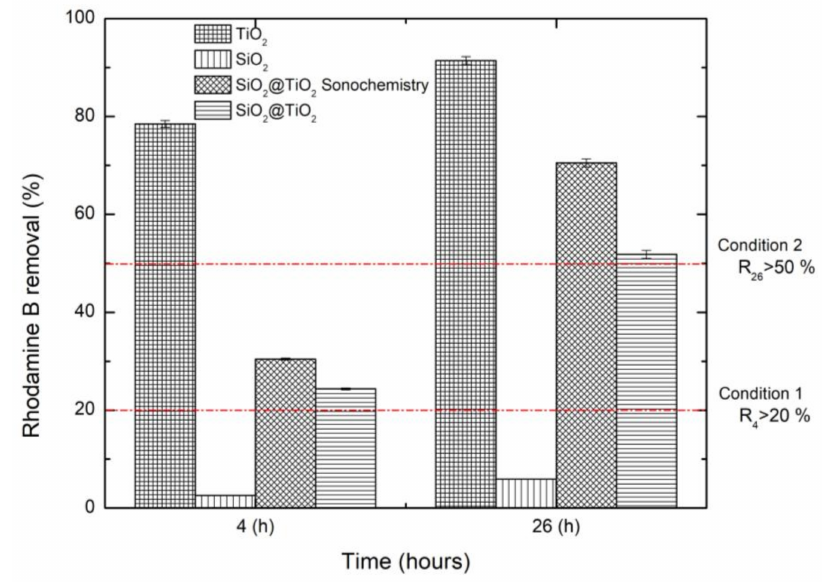
Figure 10. Rhodamine B removal efficiencies of the TiO 2 , SiO 2 and SiO 2 @TiO 2 coated mortar samples under UV-A irradiation (4 and 26